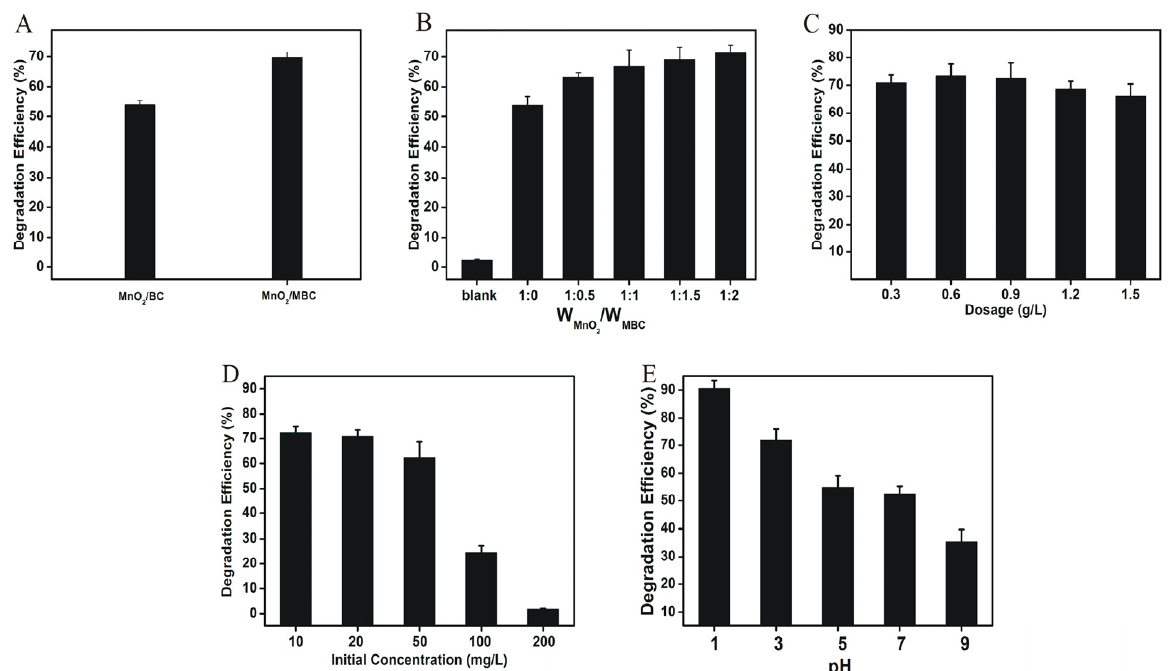
Figure 2. DE of different samples on CTC in water after sunlight irradiation for 120 min at room temperature. ( A ) MnO 2 /BC (W MnO2 /W BC = 1:2) and MnO 2 /MBC (W MnO2 /W MBC = 1:2) (dosage of 0.6 g/L, initial CTC concentration of 20 mg/L, pH = 3); ( B ) MnO 2 /MBC with different weight ratios (dosage of 0.6 g/L, initial CTC concentration of 20 mg/L, pH = 3); ( C ) SSM with different dosages (initial CTC concentration of 20 mg/L, pH = 3); ( D ) SSM with different initial CTC concentrations (dosage of 0.6 g/L, pH = 3); ( E ) SSM under different pH (dosage of 0.6 g/L, initial CTC concentration of 20 mg/L).